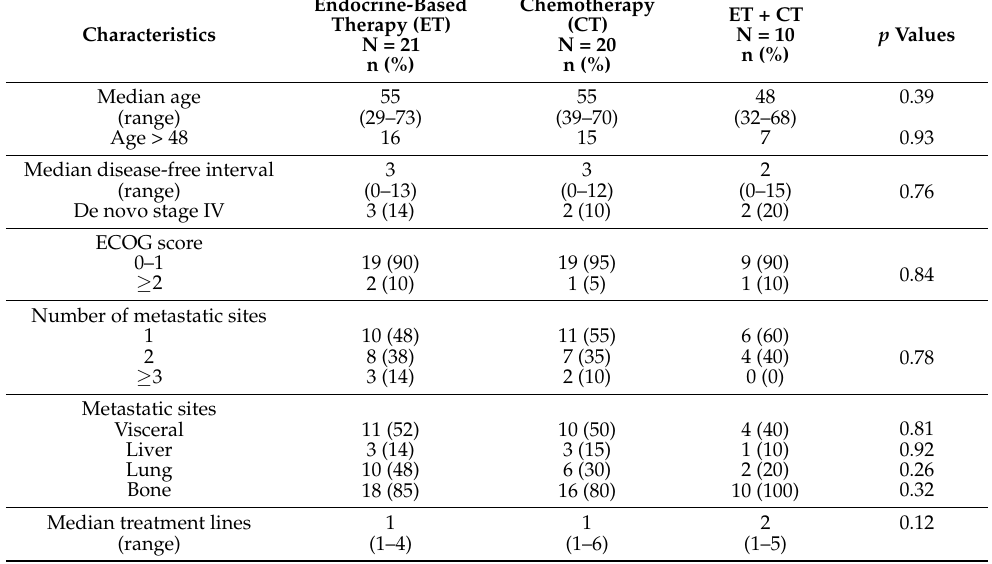
Table 1. Baseline characteristics of the patients.